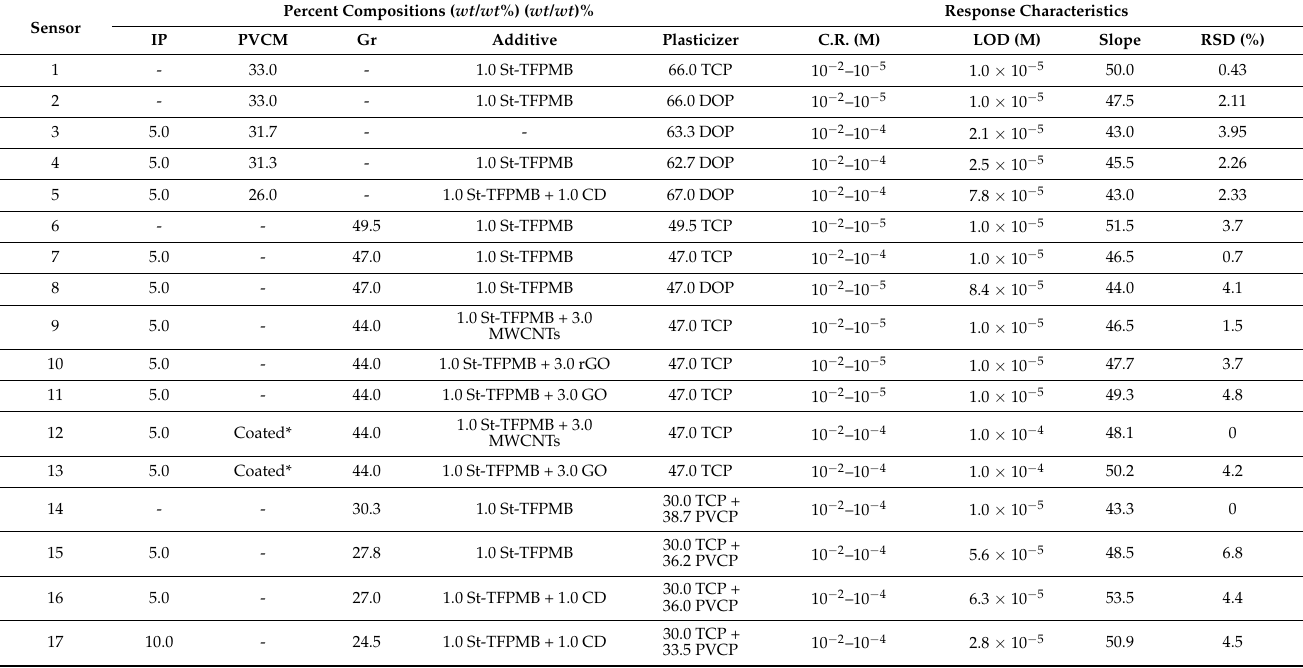
Figure 2. Formulation of the different carbon paste electrodes: carbon paste of CPEs was formulated from different amounts of conductive carbonaceous materials (Gr, GO, rGO, MWCNTs), plasticizers (TCP), ion-exchanger (St-TFPMB), and ion-pair (LF-TPB). The PVC membrane layer of C-CPEs were formulated from (LF-TPB ion-pair, TPB as a plasticizer, TCP or DOP as a plasticizer, and PVC as a polymeric matrix). P-CPEs formulated by mixing carbonaceous materials (Gr), ion-pair (LF-TPB), ion exchanger (St-TFPMB), and plasticizers (TCP, PVC/CD). The electrode compositions (%, wt / wt ) are given in (Table 1). Table 1. Percent compositions ( wt / wt %) of the different sensors and their response properties using acetate buffer at pH 4.1 at room temperature of 22 ± 2 ◦ C.